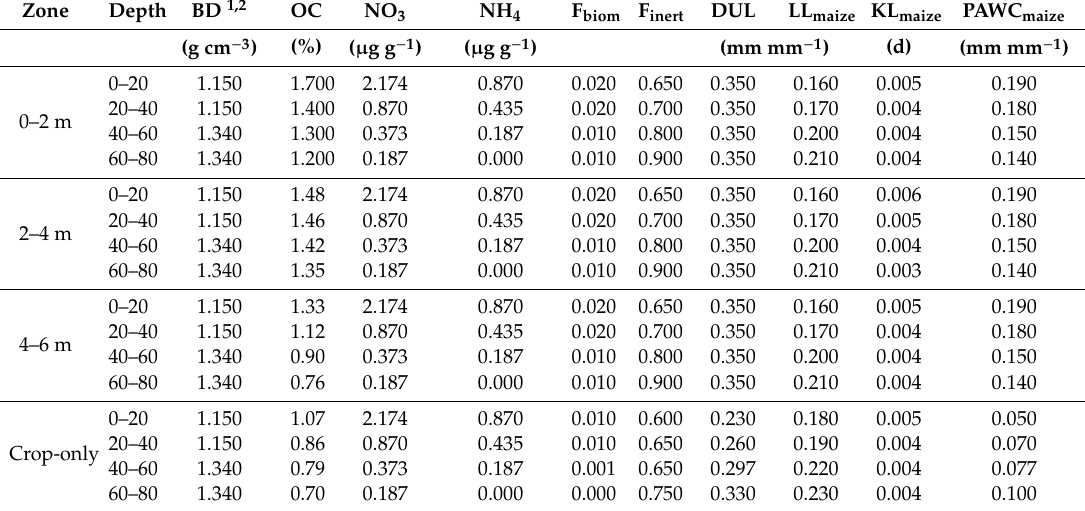
Table 3. Soil properties (0–80 cm) used for